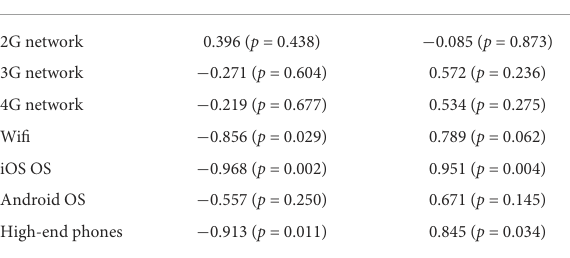
TABLE 1 Pearson correlation between the percentage of refugee users with various network/device types and income/poverty from VASyr 2019 based on data for the six governorates of